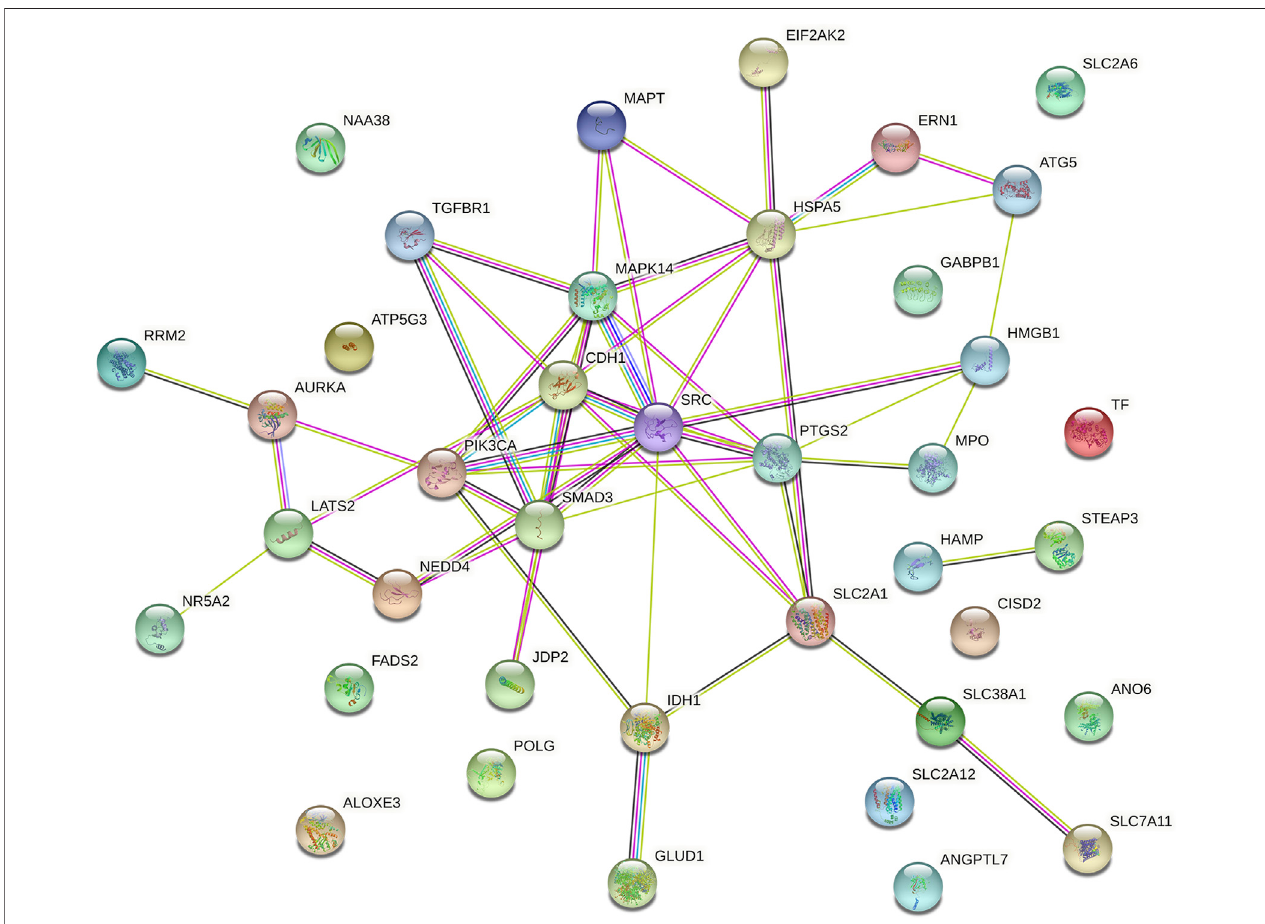
FIGURE 6 | Gene interactions and correlations plots of prognostic FRG. The gene network downloaded from the STRING database indicates the interactions among the prognostic FRG.